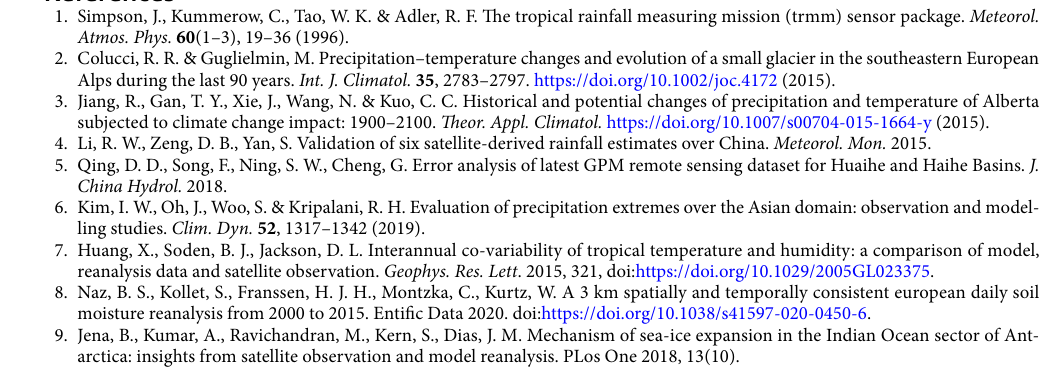
ERA5 hourly data on single levels from 1979 to present are available from the ECMWF, please visit: https:// cds. clima te. coper nicus. eu. The digital elevation data can be downloaded from the shuttle radar topography mis- sion (SRTM) digital elevation model (https:// eospso. gsfc. nasa. gov/ missi ons/ shutt le- radar- topog raphy- missi on).